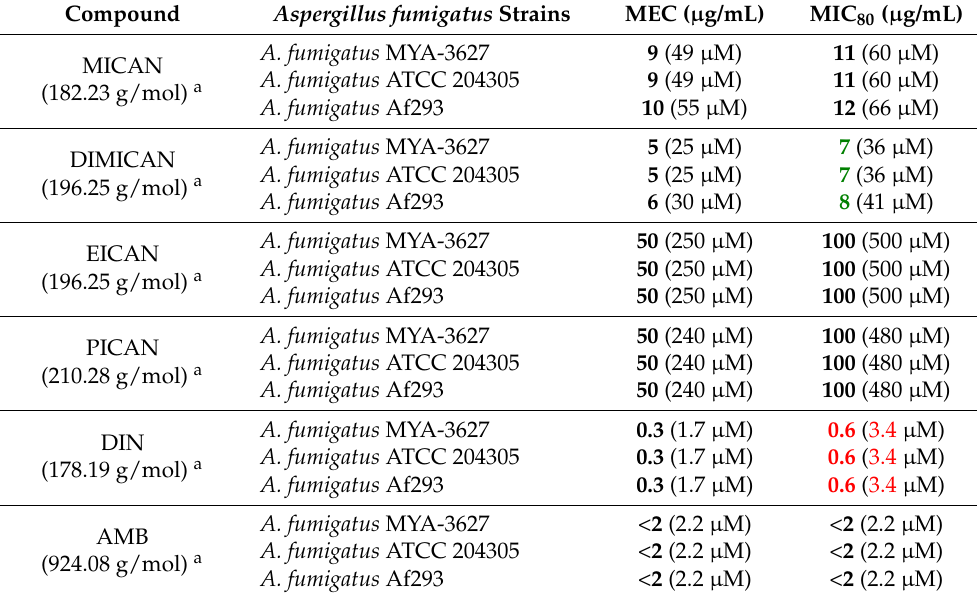
Table 1. In vitro susceptibilities of Aspergillus fumigatus to MICAN, DIMICAN, EICAN, PICAN and DIN as determined by CLSI broth microdilution method. Minimum effective concentration (MEC) and 80% inhibitory (MIC 80 ) values are presented. The values in parentheses belong to the molar concentration of the compounds. The best and second-best MIC values are indicated in red and green,